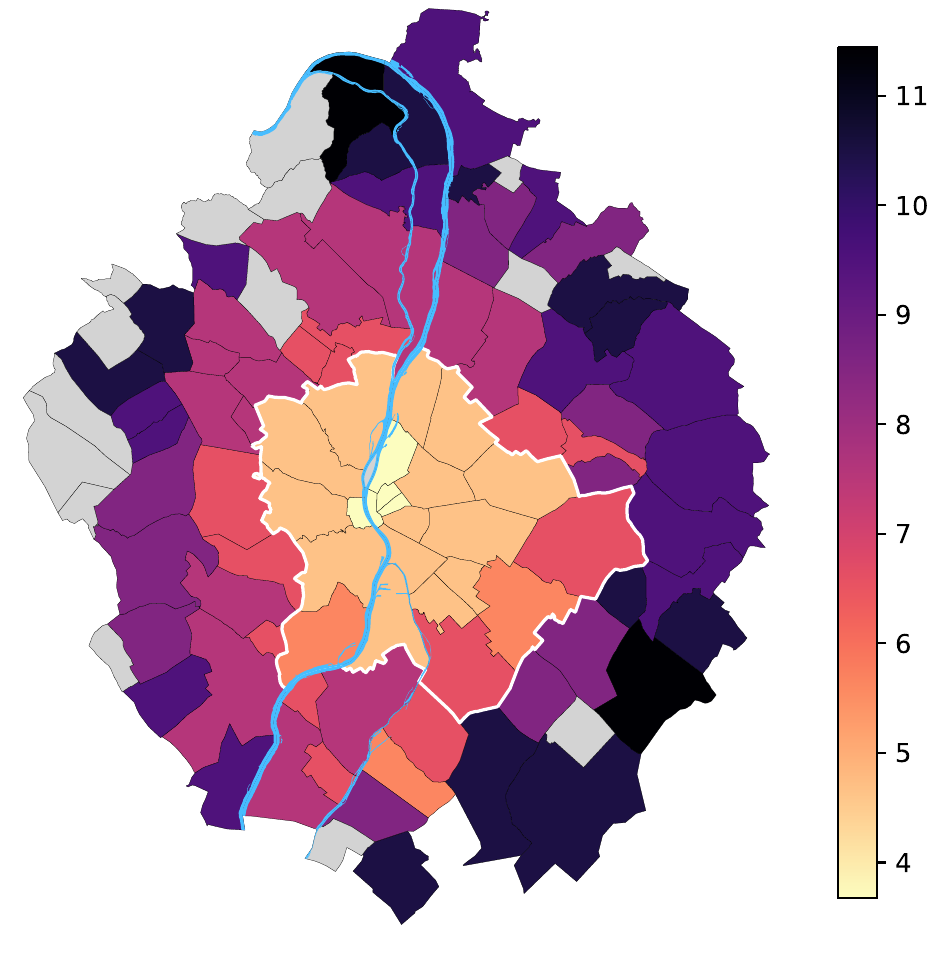
Figure 10. Budapest districts and the settlements of the agglomeration colored by the mean Radius of Gyration (km) for workdays. The tendency is that the farther lives someone from the city center the more one travels. The white border denotes the administrative border of Budapest and the Danube is displayed by light